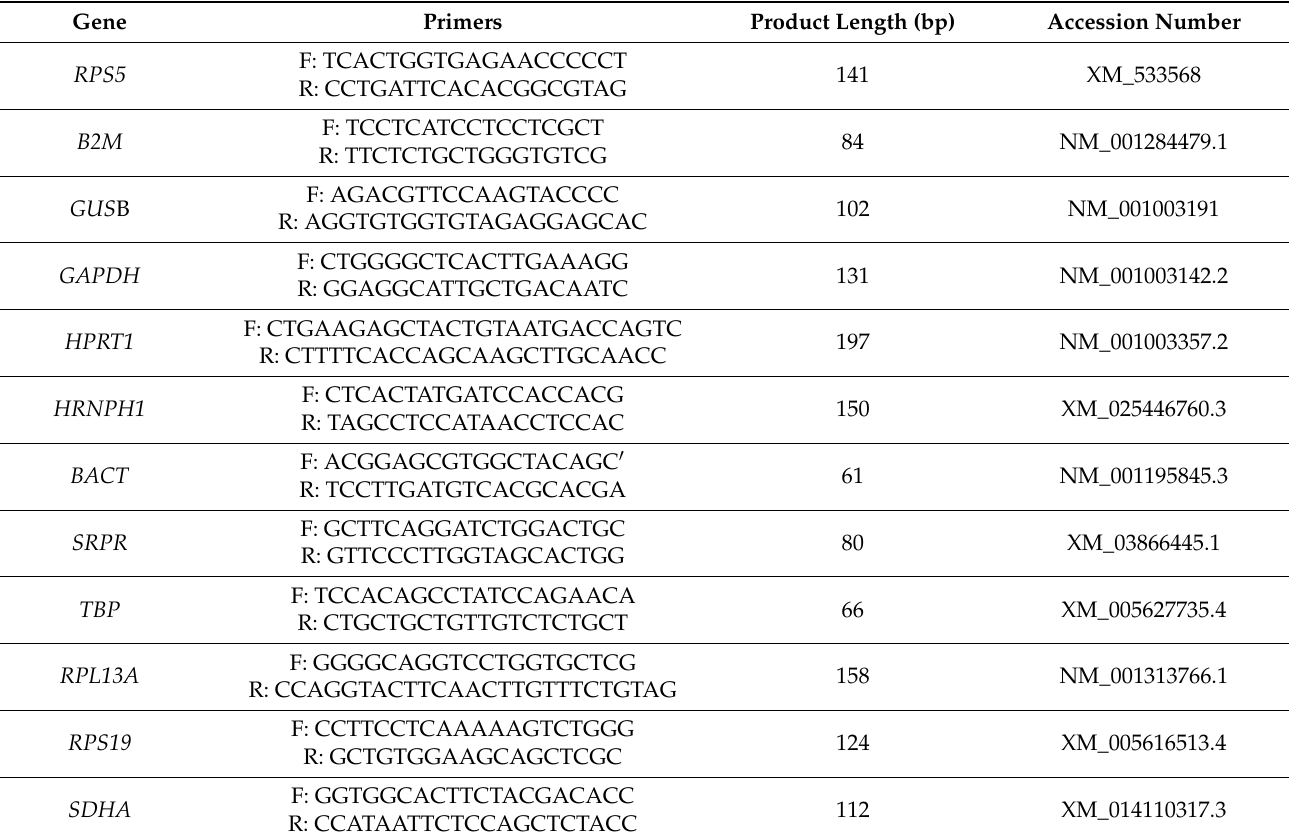
Table 1. Canine reference genes: details of primers and amplicons for each evaluated